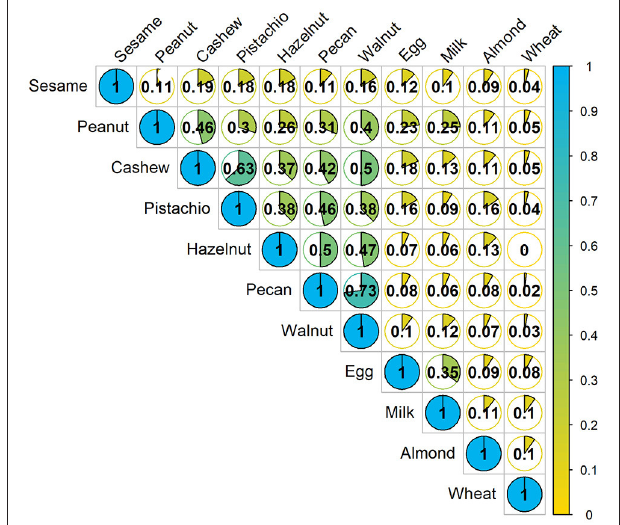
FIGURE 2 | Concurrent occurrences of food allergy based on food challenge outcomes: The fraction in each cell represents the Jaccard similarity coefficient, which is the amount of co-allergy accounting for the number of positive challenges for each allergen separately. Higher values indicate more similarity between the two allergens. Denominator only includes participants who were screened for multi-food allergy studies.